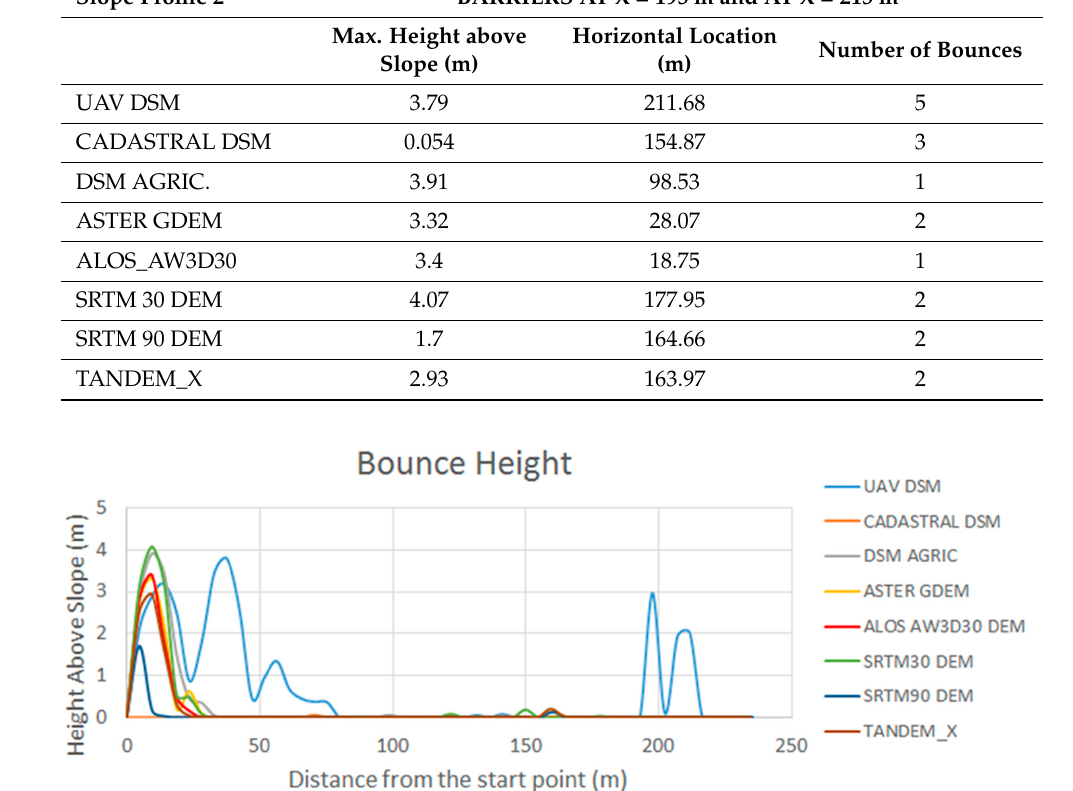
Table 12. Bounce height for the 2nd slope profile. Slope Profile 2